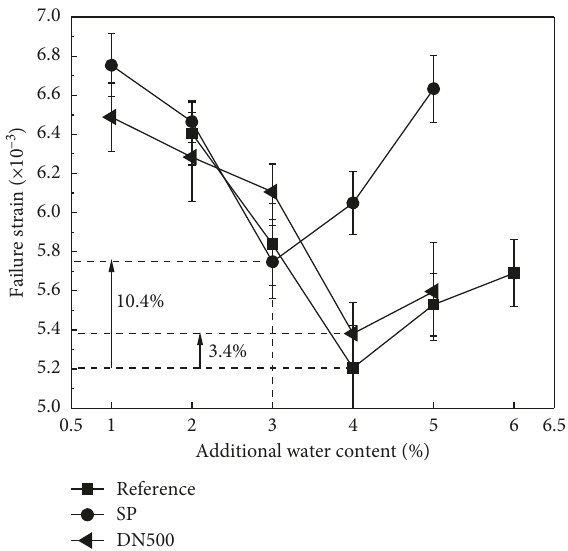
Figure 9: The failure strain of CRME with different additional water contents and surfactants.